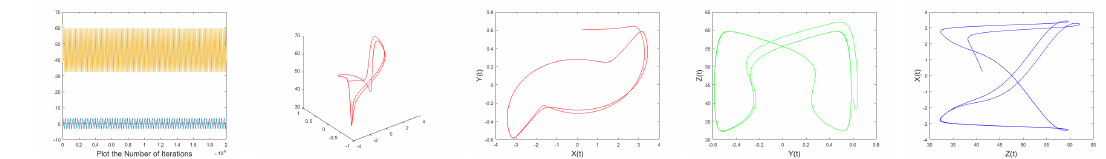
Fig. 8 Unstable trajectories which are away from the equilibrium point ( 3 . 65333 , 0 . 405925 , 41 ) in the system D 52 , 41 , 9 [ 15 ] . 1.3 Stability of the Fixed Point (